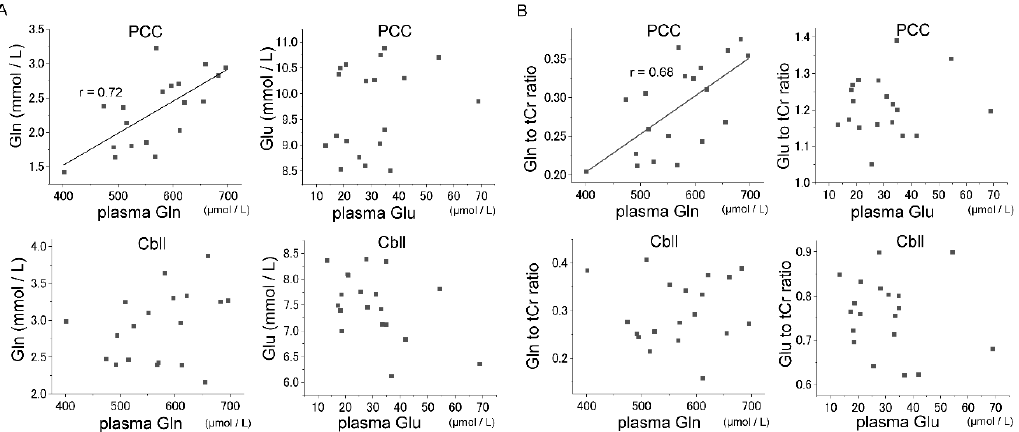
Figure 2. Correlations between plasma glutamate–glutamine (Glu-Gln) and cerebral Glu-Gln. Significant positive correlations between Gln concentrations in plasma and PCC (mean of two measurements) were found ( p < 0.01, r = 0.72). No significant correlation was noted between Gln in plasma and Cbll. Glu did not show any significant correlations between brain and plasma ( A ). Significant positive correlations were found between Gln in plasma and the Gln to tCr ratio (mean of two measurements) in PCC ( p < 0.01, r = 0.68). No other correlations were found ( B ).